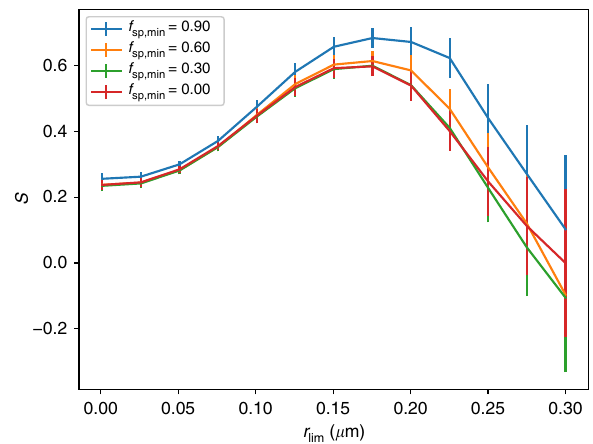
Fig. 1 Dependence of susceptibility on size and shape. Susceptibility S as function of minimum particle radius r for different values of the minimum lim fraction of spherical particles ( f ). Error bars indicate the standard error sp ; min (2 σ ) of the linear